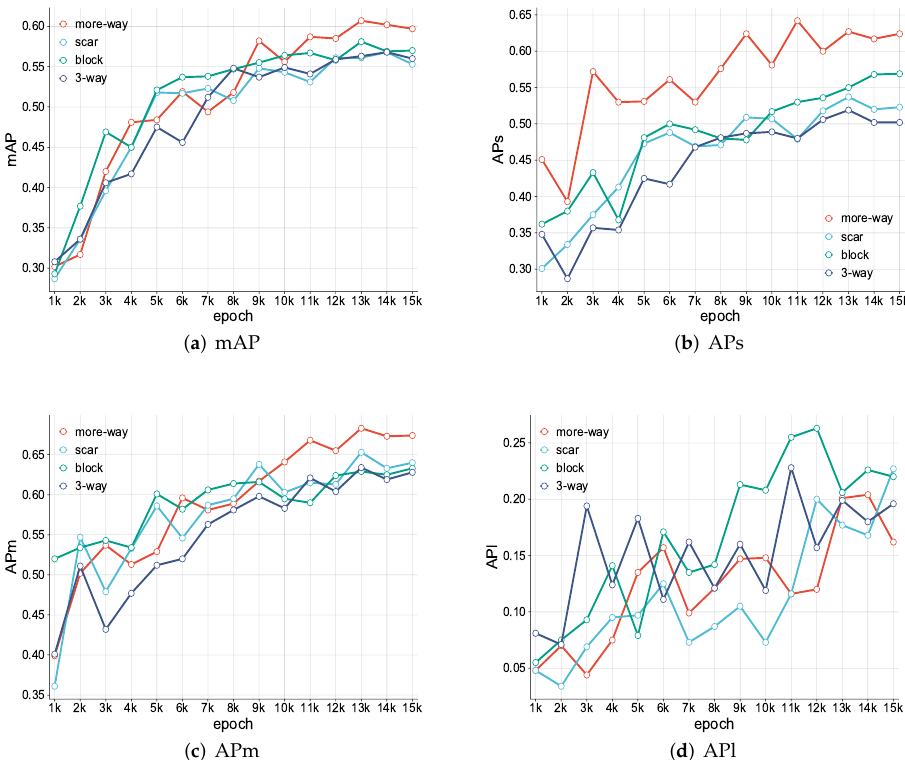
Figure 6. Variation of the accuracies of SS R-CNN with different CutPaste tasks. We wonder how the more-way CutPaste task improves detection performance for small ships. Hence, we examine the detected objects of SS R-CNN with various CutPaste tasks. Some typical images with multiple small ships with their detection boxes are selected and are displayed in Figure